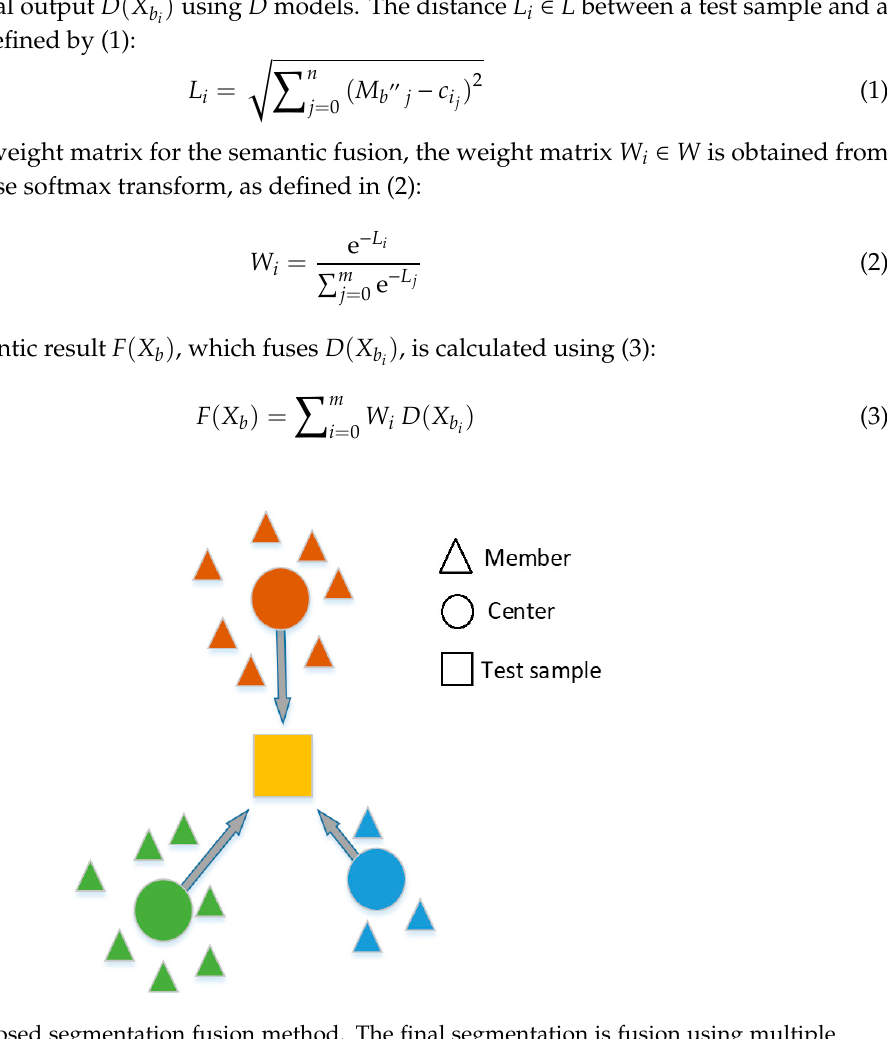
Figure 10. Proposed segmentation fusion method. The final segmentation is fusion using multiple semantic groups (the red, blue and green colors represent different semantic grouping spaces, the yellow square represents the final segmentation result).